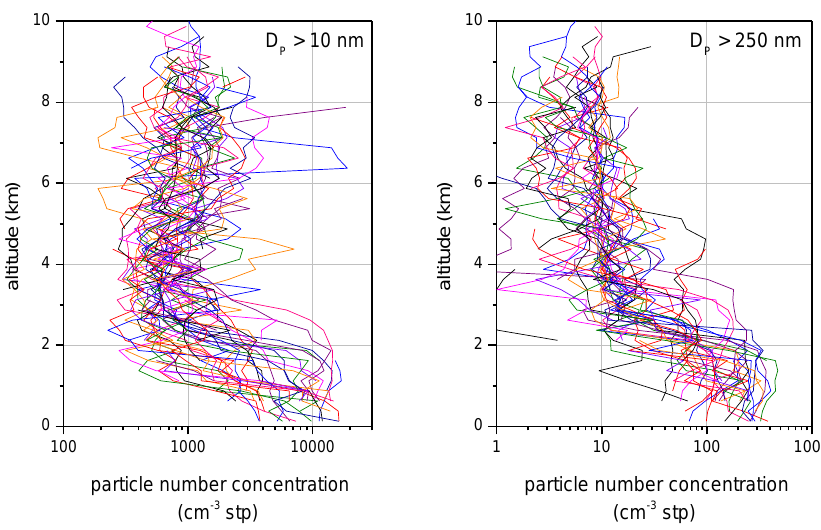
Fig. 8. Vertical distribution of aerosol particles > 10nm (left panel) and > 250nm (right panel) over Europe during May 2010 from 43 individual vertical profiling missions with the DLR Falcon aircraft, measured by condensation and optical particle counters (see Hamburger et al. (2011) for details). In-cloud data are excluded. Number concentration refers to standard conditions (STP) 273K and 1013hPa.